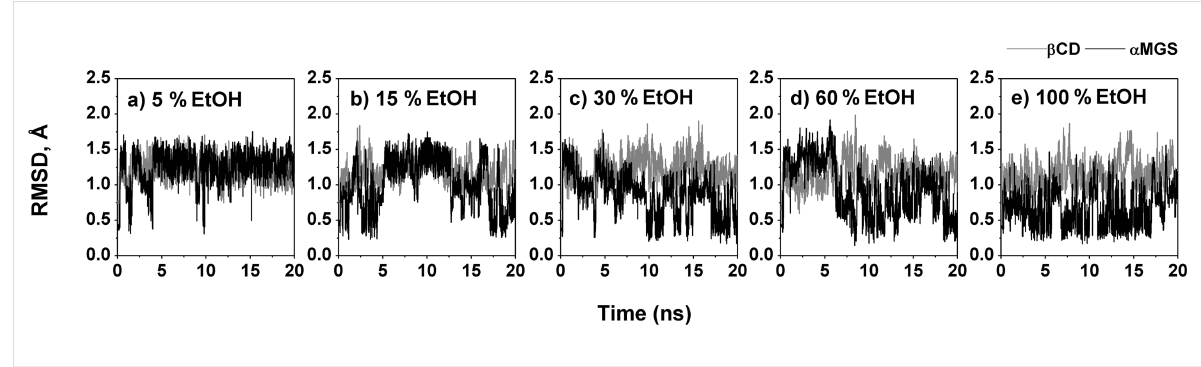
Figure 4: RMSD plots of β -CD (grey) and α -MGS (black) for the five systems with different ethanol percentages.